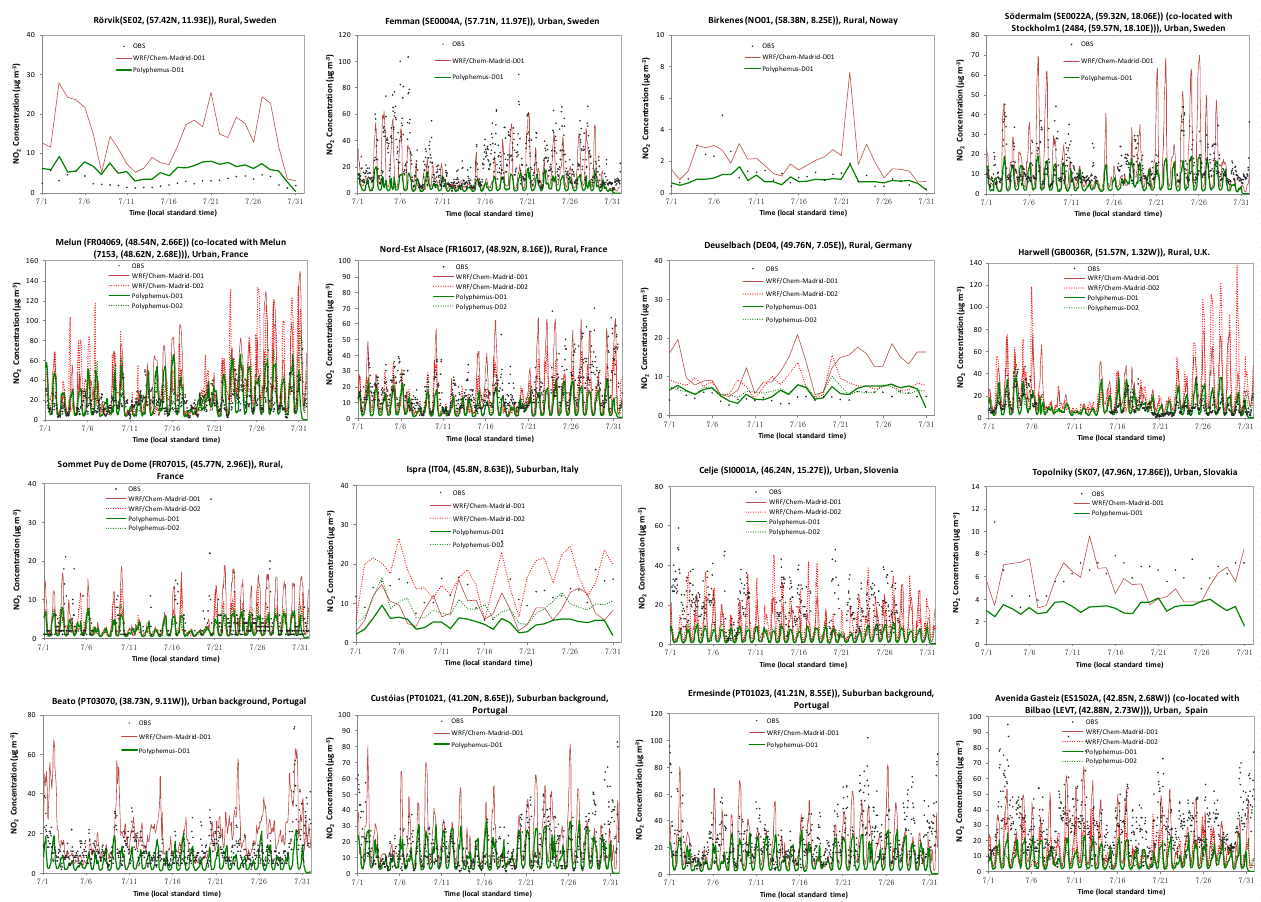
Figure 4. Simulated and observed hourly or daily concentrations of NO 2 in July 2001 at selected sites over D01 and D02 in four latitude bands: 57-60 ºN, 48-52 ºN, 45-48 ºN, and 38-43 ºN (rows 1, 2, 3, and 4, respectively).